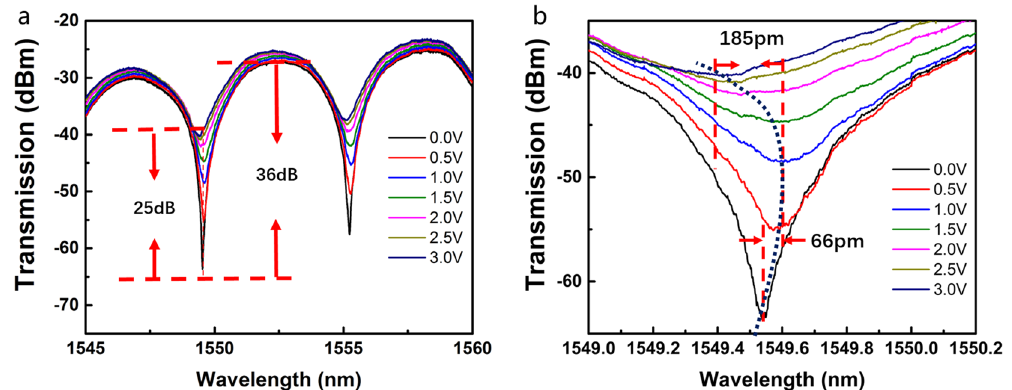
Figure 5. ( a ) Static spectra under different applied voltages. ( b ) Detailed spectra under different applied